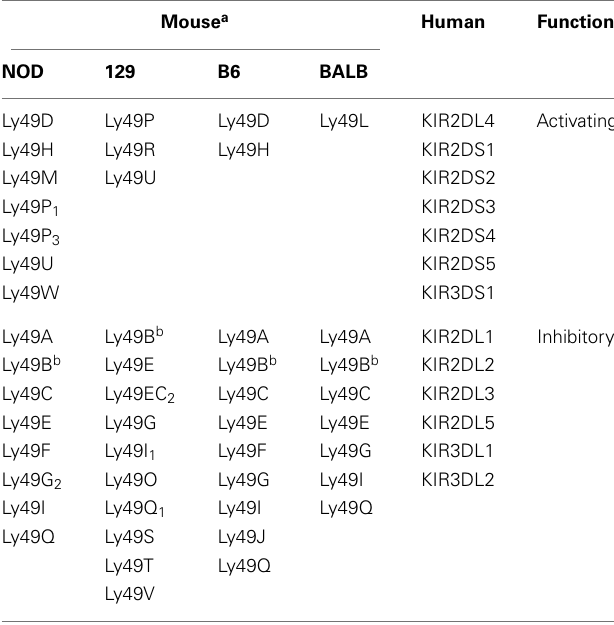
Table 1 | Mouse Ly49 and human KIR receptors for MHC-I.